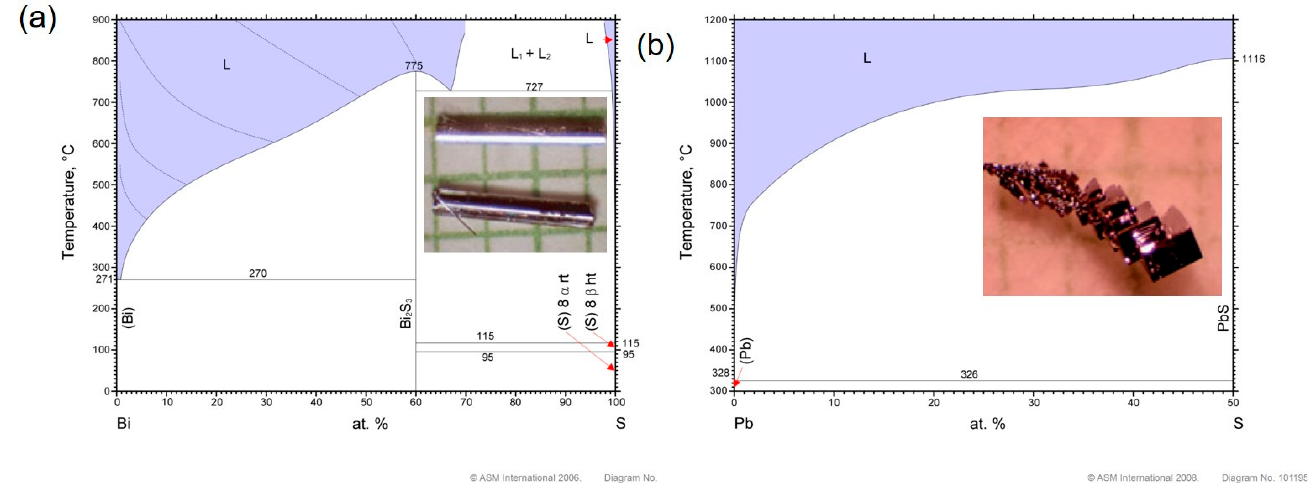
Figure 1. Binary phase diagram of ( a ) Bi-S (ASM diagram #981133) [22] and ( b ) Pb-rich side of Pb-S (ASM diagram #101195) [23]. Note: dotted lines in ( a ) indicate isobars at (from top) 10 5 , 10 3 , 10, 10 − 1 and 10 − 3 Pa. The inset in ( a ) is a picture of Bi 2 S 3 crystals, and the inset in ( b ) is a picture of PbS crystals. The crystals in each picture are on a mm grid.